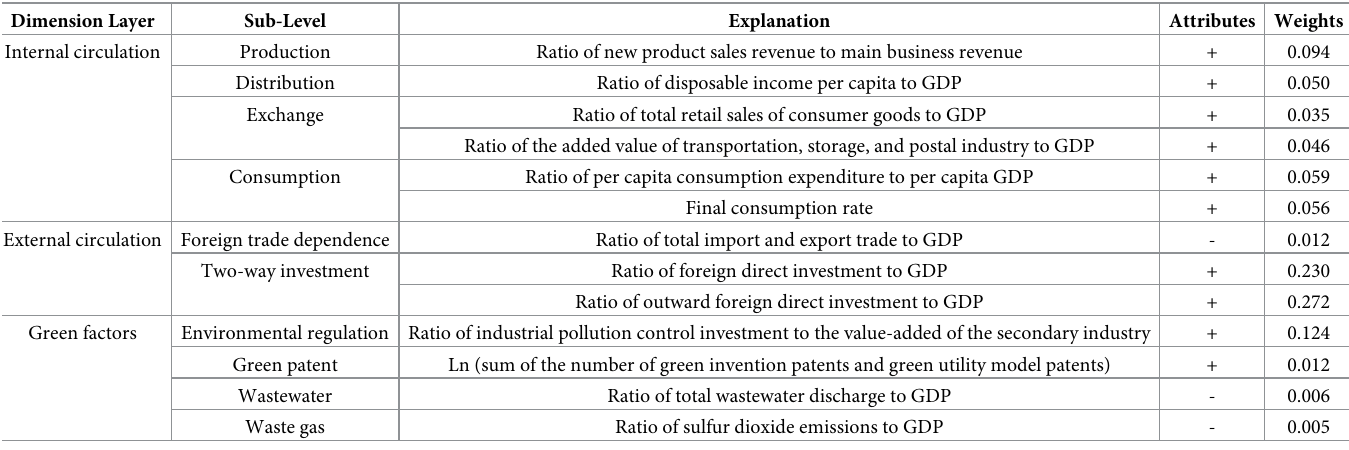
Table 1. Comprehensive evaluation index system of